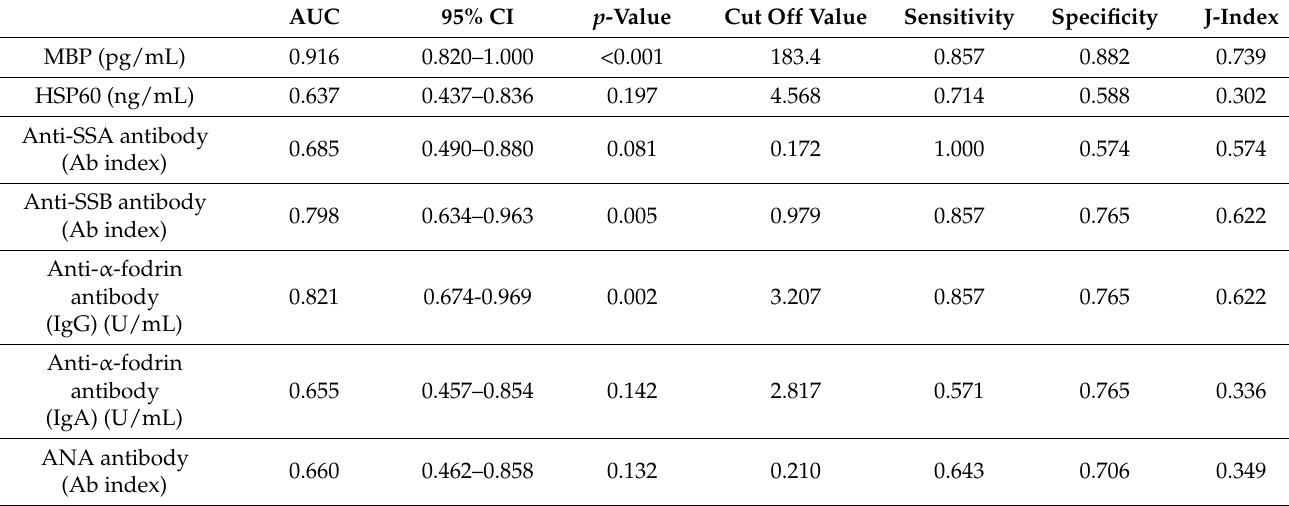
antigen B; ANA = anti-nucleic acid.